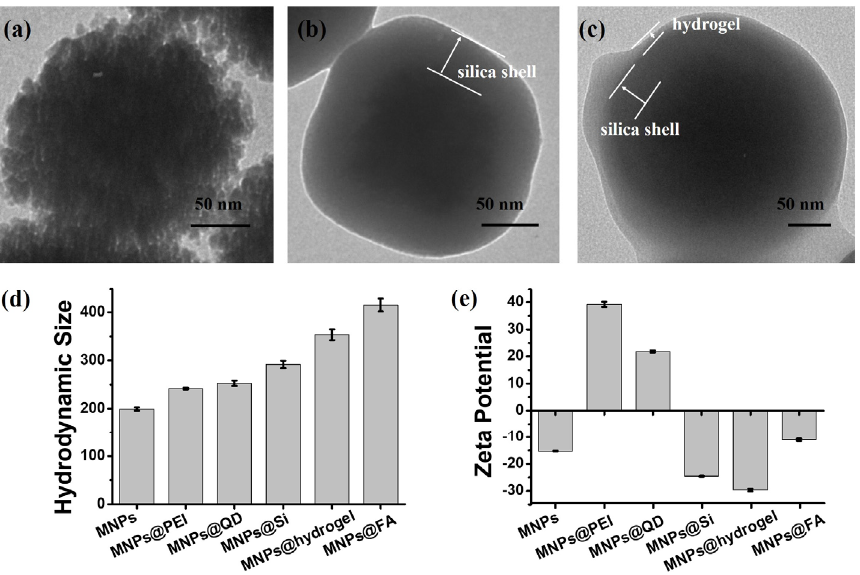
Figure 2. Transmission electron microscope (TEM) images of ( a ) MNPs@QD, ( b ) MNPs@Si, and ( c ) MNPs@hydrogel. Comparison of hydrodynamic size ( d ) and zeta potential ( e ) by the DLS and zeta potential measurement for the nanoparticles with different modifications. All data are expressed as the mean ± stand deviation, n =